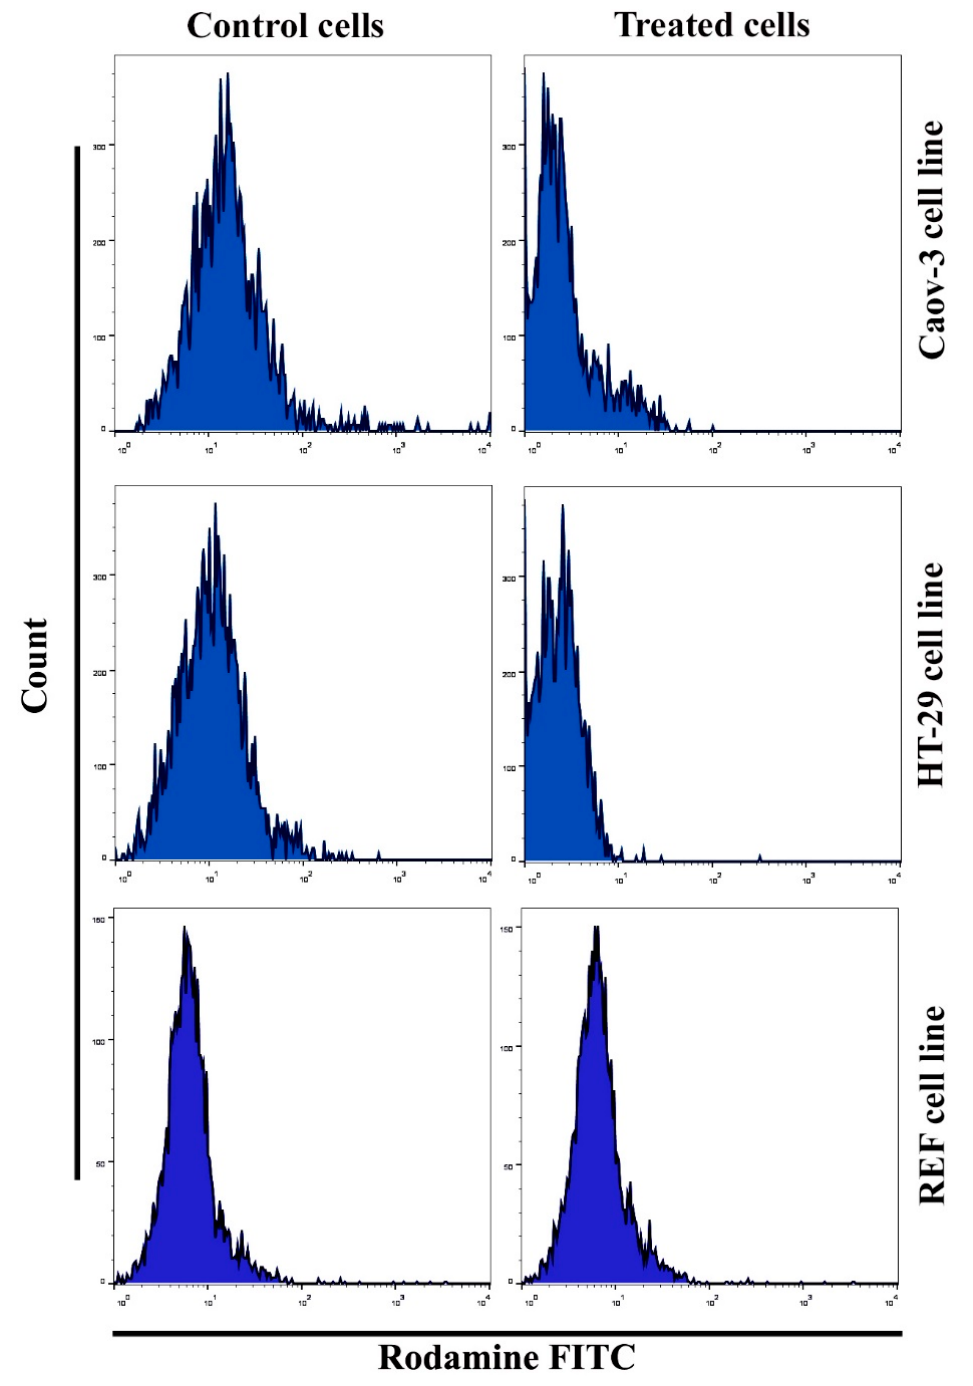
Figure 4. Effect of [Pt(H 2 L)(PPh 3 )] complex on the loss of mitochondrial membrane potential.